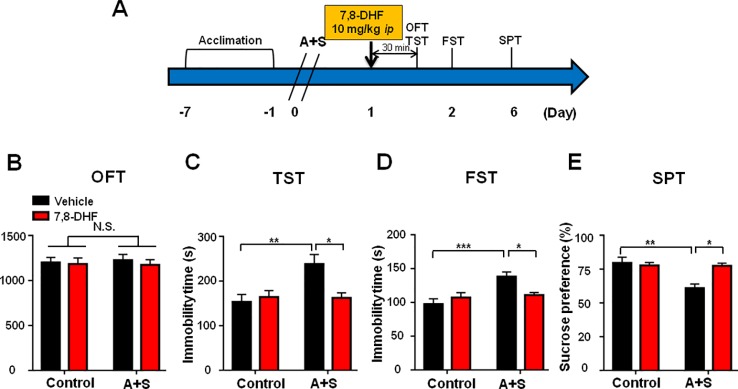
7,8-DHF pretreatment alleviated POD-like symptoms. (A) The schedule of treatment and behavioral tests. 7,8-DHF was administered on day 1 after A+S, behavioral tests, including OFT, TST, FST, and SPT were performed on day 1, 2, and 5 after A+S, respectively. (B) OFT [Group: F
(1,
28) = 0.0137, P = 0.9075; 7,8-DHF: F
(1,
28) = 0.3176, P = 0.5793; interaction: F
(1,
28) = 0.0795, P = 0.7801]. (C) TST [Group: F
(1,
28) = 6.163, P = 0.0196; 7,8-DHF: F
(1,
28) = 3.817, P = 0.0612; interaction: F
(1,
28) = 6.835, P = 0.0144]. (D) FST [Group: F
(1,
28) = 11.07, P = 0.0025; 7,8-DHF: F
(1,
28) = 1.726, P = 0.1996; interaction: F
(1,
28) = 7.659, P = 0.0099]. (E) SPT [Group: F
(1,
28) = 9.821, P = 0.004; 7,8-DHF: F
(1,
28) = 5.896, P = 0.0218; interaction: F
(1,
28) = 9.308, P = 0.005]. Data are shown as mean ± SEM (n = 8). *P < 0.05, **P < 0.01 or ***P < 0.001. 7,8-DHF: 7,8-dihydroxyflavone; A+S: anesthesia and surgery; FST: forced swimming test; N.S.: not significant; OFT: open field test; POD, postoperative depression; SPT, sucrose preference test; TST, tail suspension test.